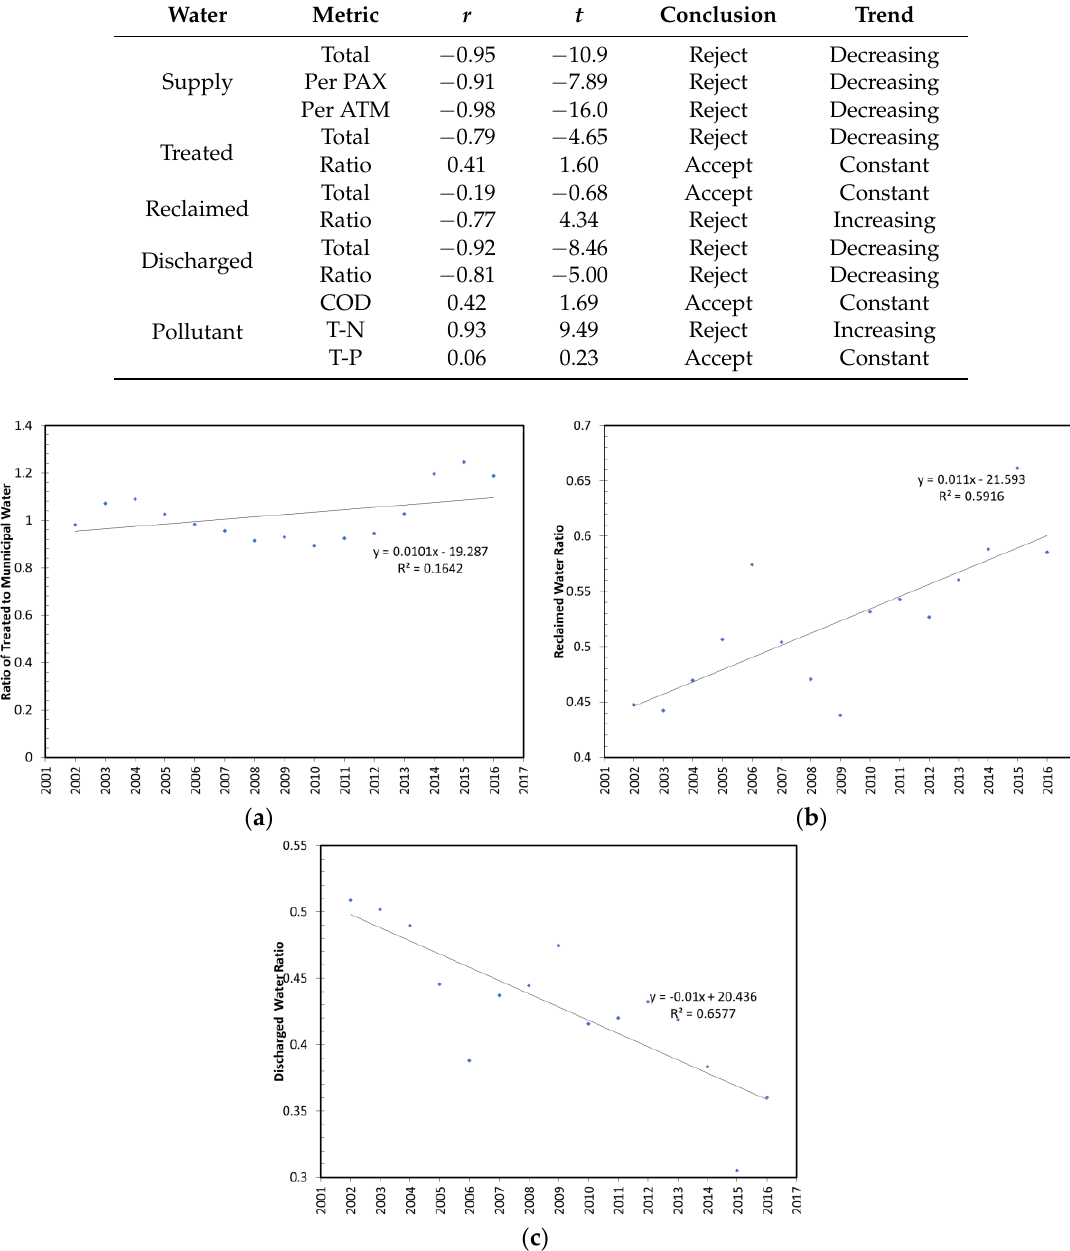
Figure 7. The scatter plot showing the line of best fit and correlation coefficient (squared) of KIX 2002–2016 annual water ratios: ( a ) treated to supply, ( b ) reclaimed to treated, and ( c ) discharged to treated. Source: Data derived from References [12,13]. Table 2. The correlation assessment of water parameters for various metrics, all testing at the 95% confidence level, with 12 degrees of freedom, using a one-tailed test, with t crit = 1.77.